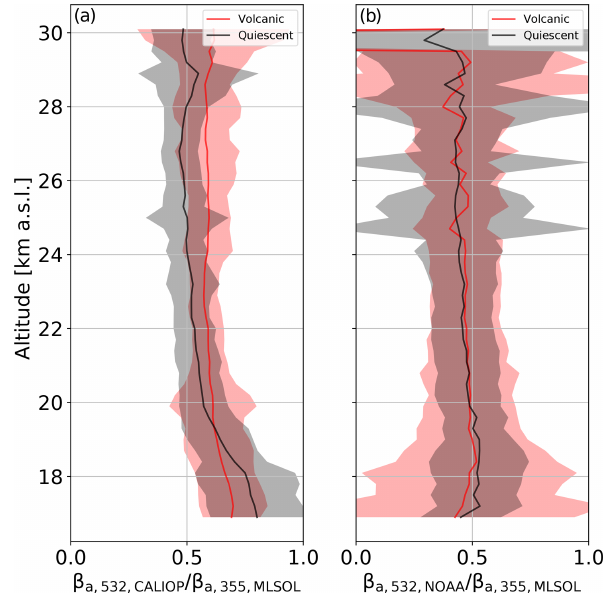
Figure 8. Average color ratio for the volcanic (solid red) and second quiescent (solid black) periods derived from CALIOP and MLSOL measurements (a) and NOAA lidar and MLSOL measurements (b) . The 1 σ variability is indicated by the shaded